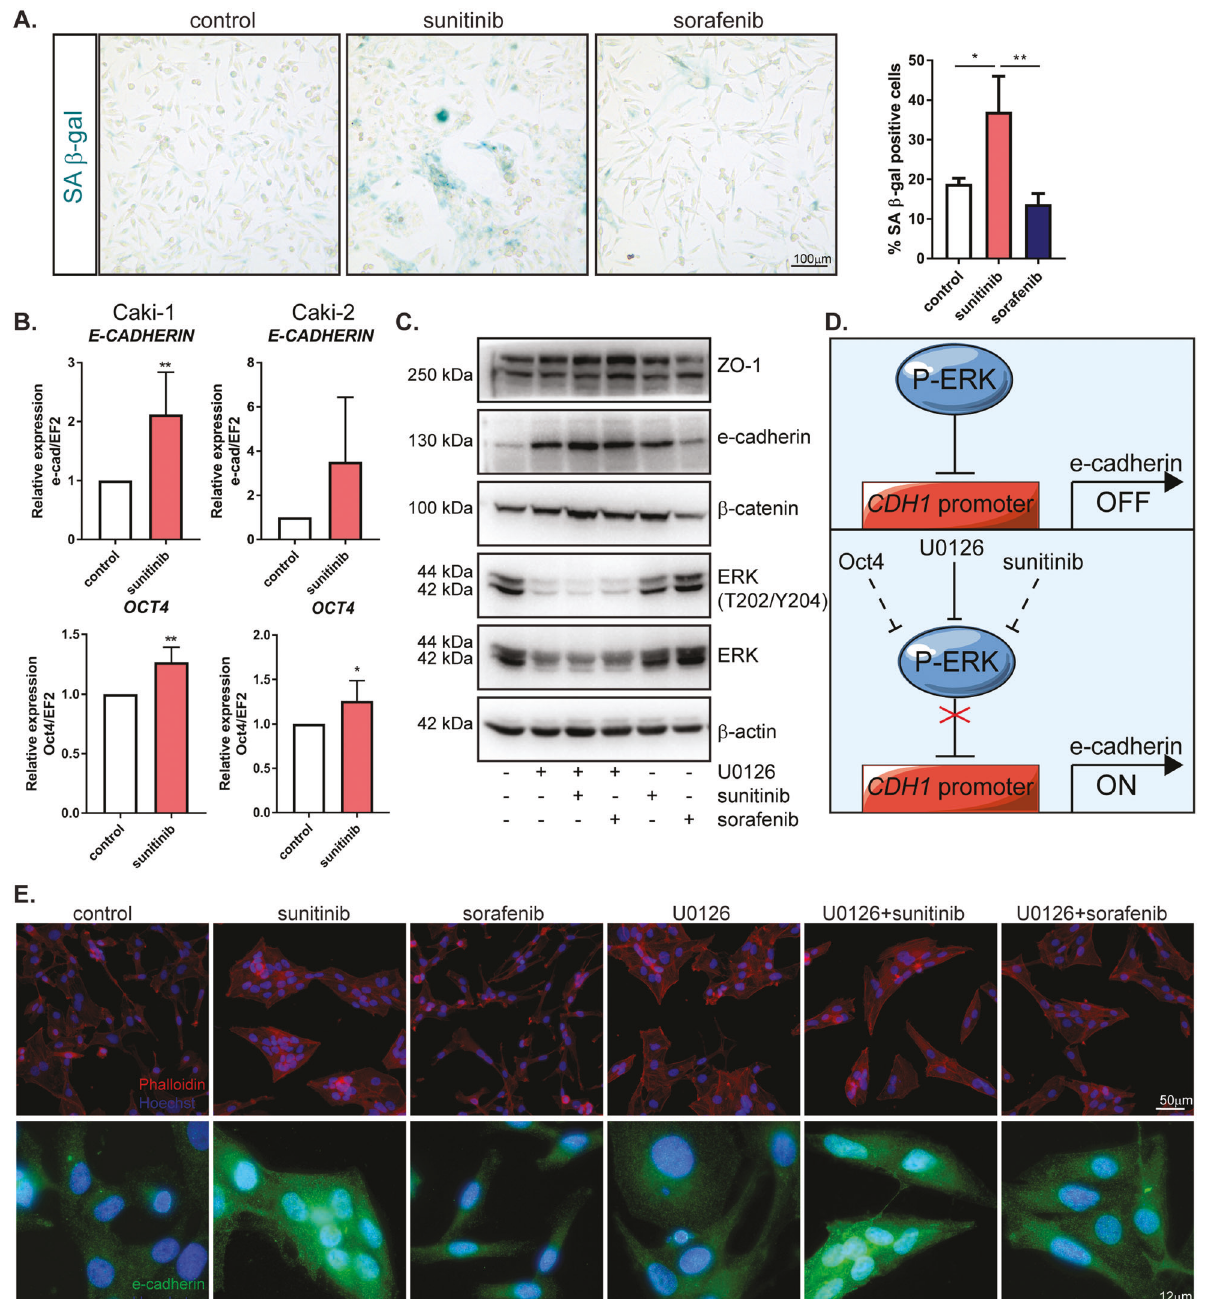
Fig. 3 Mechanism of sunitinib resistance. A Representative images after SA β -gal staining on Caki-1 cells after 1 week of drug treatment. The graph represents the quanti fi cation of SA β -gal positive cells to all cells. B mRNA level of E-CADHERIN and OCT4 in Caki-1 and Caki-2 cells after 24 h treatment with drugs, quanti fi ed with real-time PCR. The results are presented as the mean ± SD of three independent experiments. P values were estimated using one-way ANOVA with post hoc Tukey ’ s multiple comparison test. * P < 0.05; ** P < 0.01; *** P < 0.001. C Representative western blot of Caki-1 cells after 24-h treatment with the ERK inhibitor U0126 or in combination with sunitinib or sorafenib. β -actin was used as a loading control. D Schematic representation of the role of ERK in E-cadherin expression. ERK phosphorylation inhibits the CDH1 promoter which leads to decreased E-cadherin expression. ERK activity might be blocked directly by speci fi c inhibitor U0126 or indirectly by Oct4 or sunitinib. E Representative images after immuno fl uorescence staining of phalloidin and E-cadherin on Caki-1 cells after 24-h treatment with U0126, sunitinib or sorafenib. Hoechst was used to visualize nuclei. Experiments were performed at least three